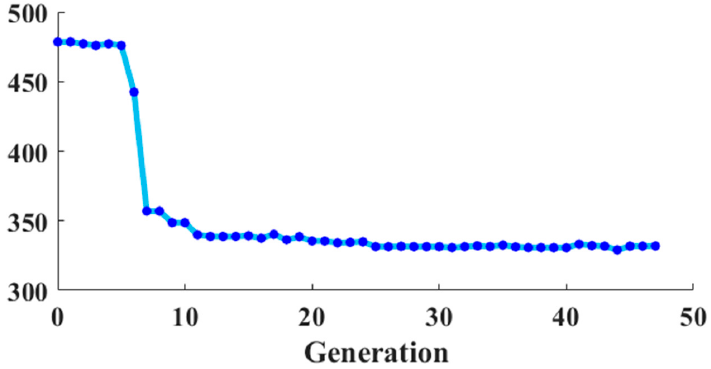
Figure 7. The GA-based convergence curve for the system under investigation.